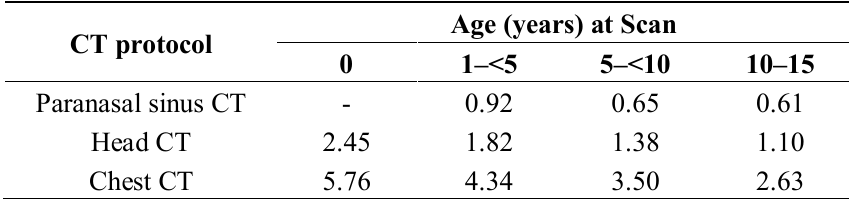
Table 4. Radiation dose (mGy) in the thyroid, by age, using the three CT protocols.